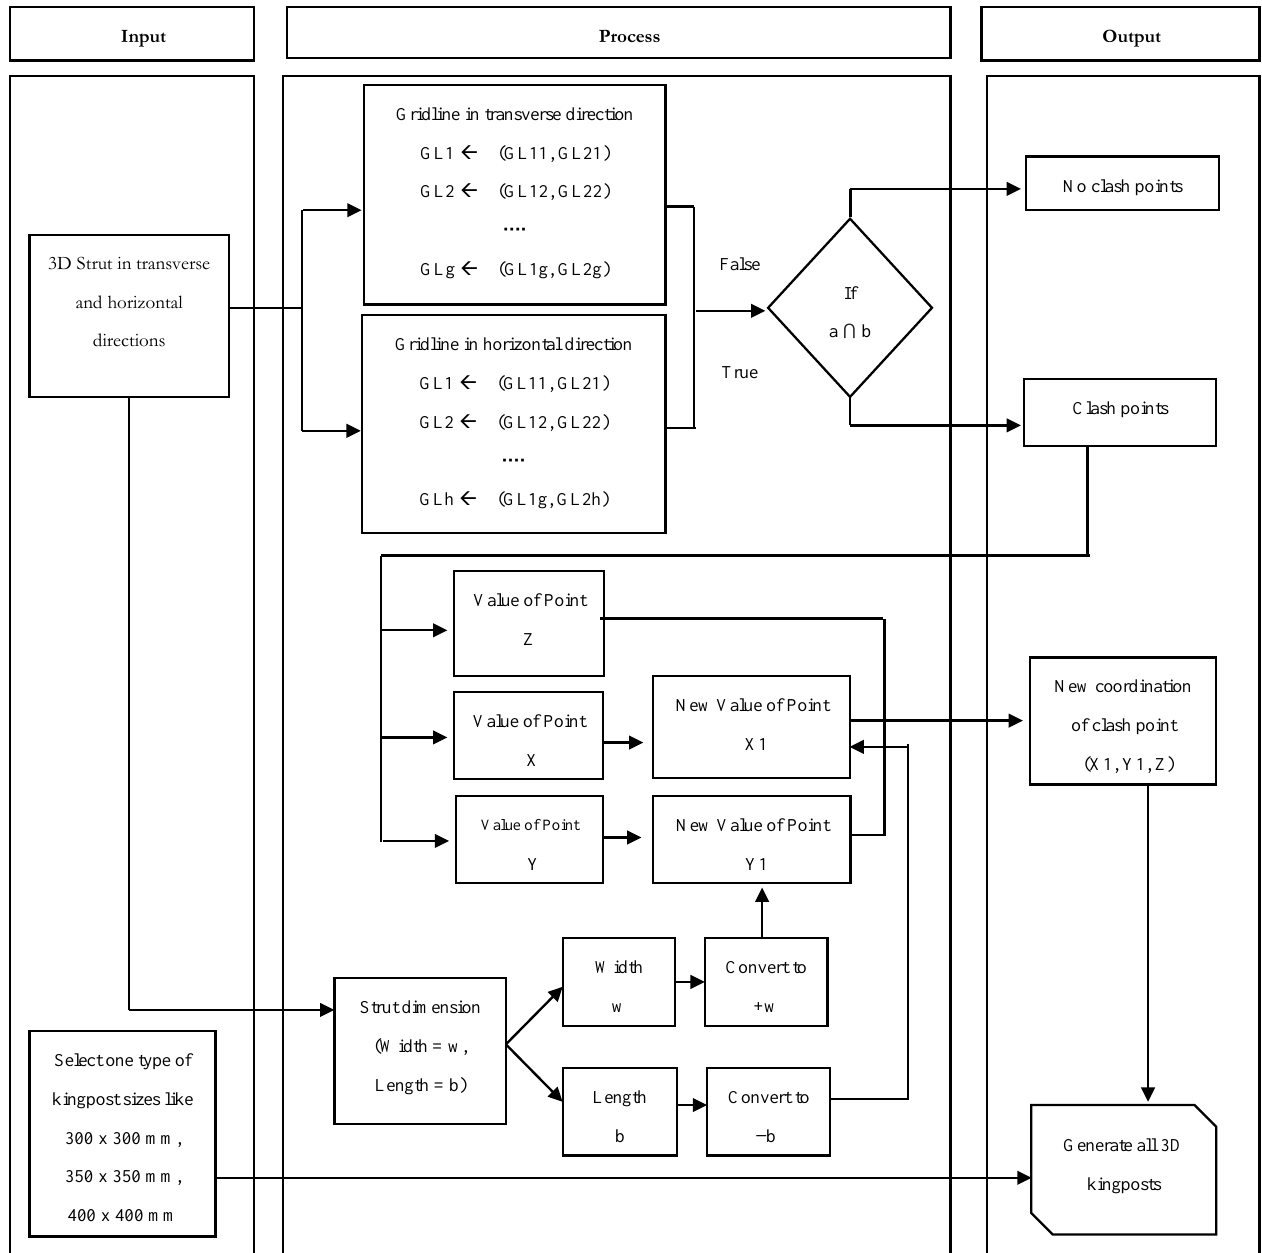
Figure 11. A module of structural kingpost generation.